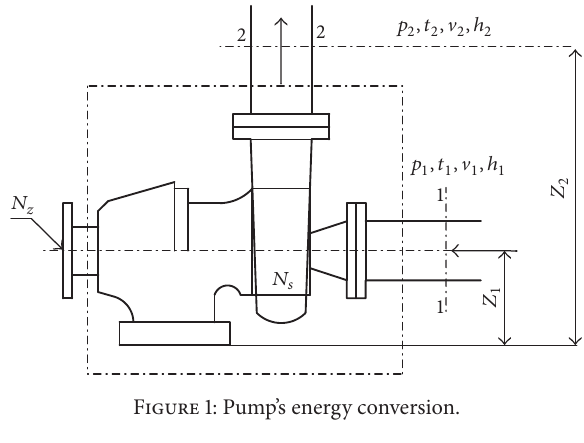
Figure 1: Pump’s energy conversion.